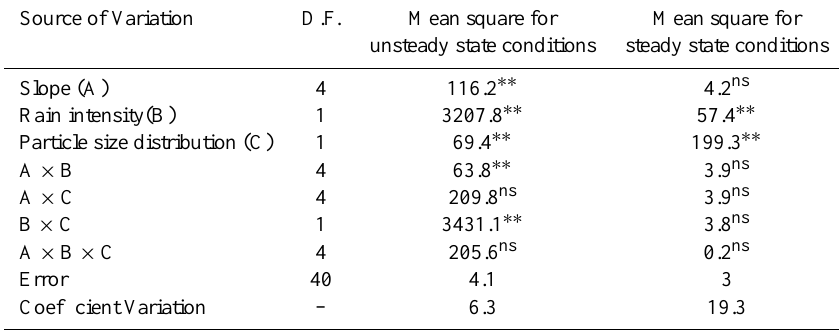
Table 2. Analysis of variance for the applied treatments on measured infiltration rate under unsteady and steady state conditions. Source of Variation D.F. Mean square for Mean square for